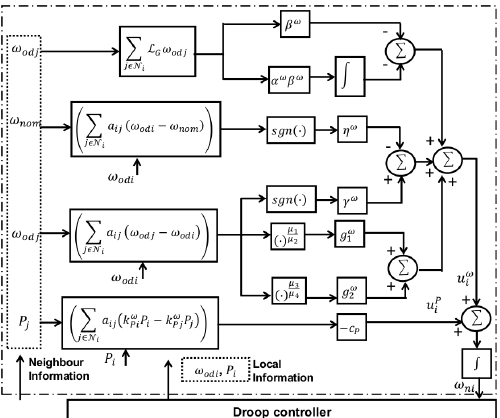
Figure 3. Block diagram of proposed secondary frequency and active power regulation